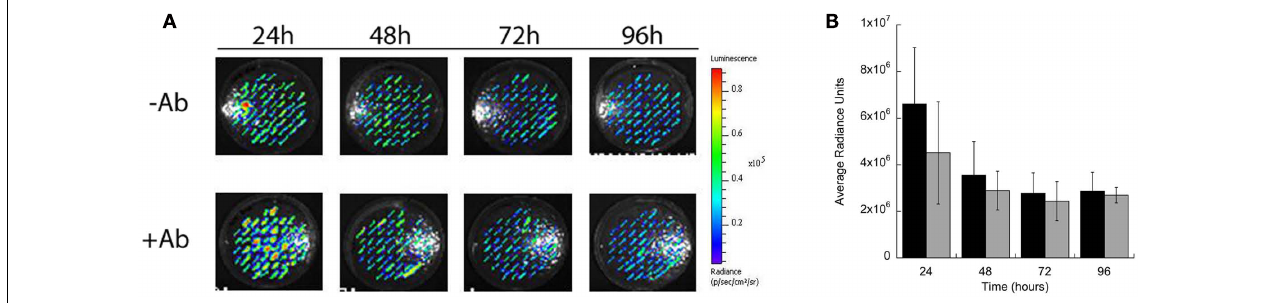
FIGURE 1 | Stability assessment of mini-Tn5:: luxKm2. (A) The stability of the mini-Tn5:: lux Km2 transposon insertion in CSM001was assessed by sub-culturing bacteria daily over 4days in the presence and absence of antibiotic. (B) Each colony was selected as a region of interest and quantified using the Living Image software. Insertion stability is expressed as the average radiance units (p/sec/cm 2 /sr) ± SEM from three independent experiments.